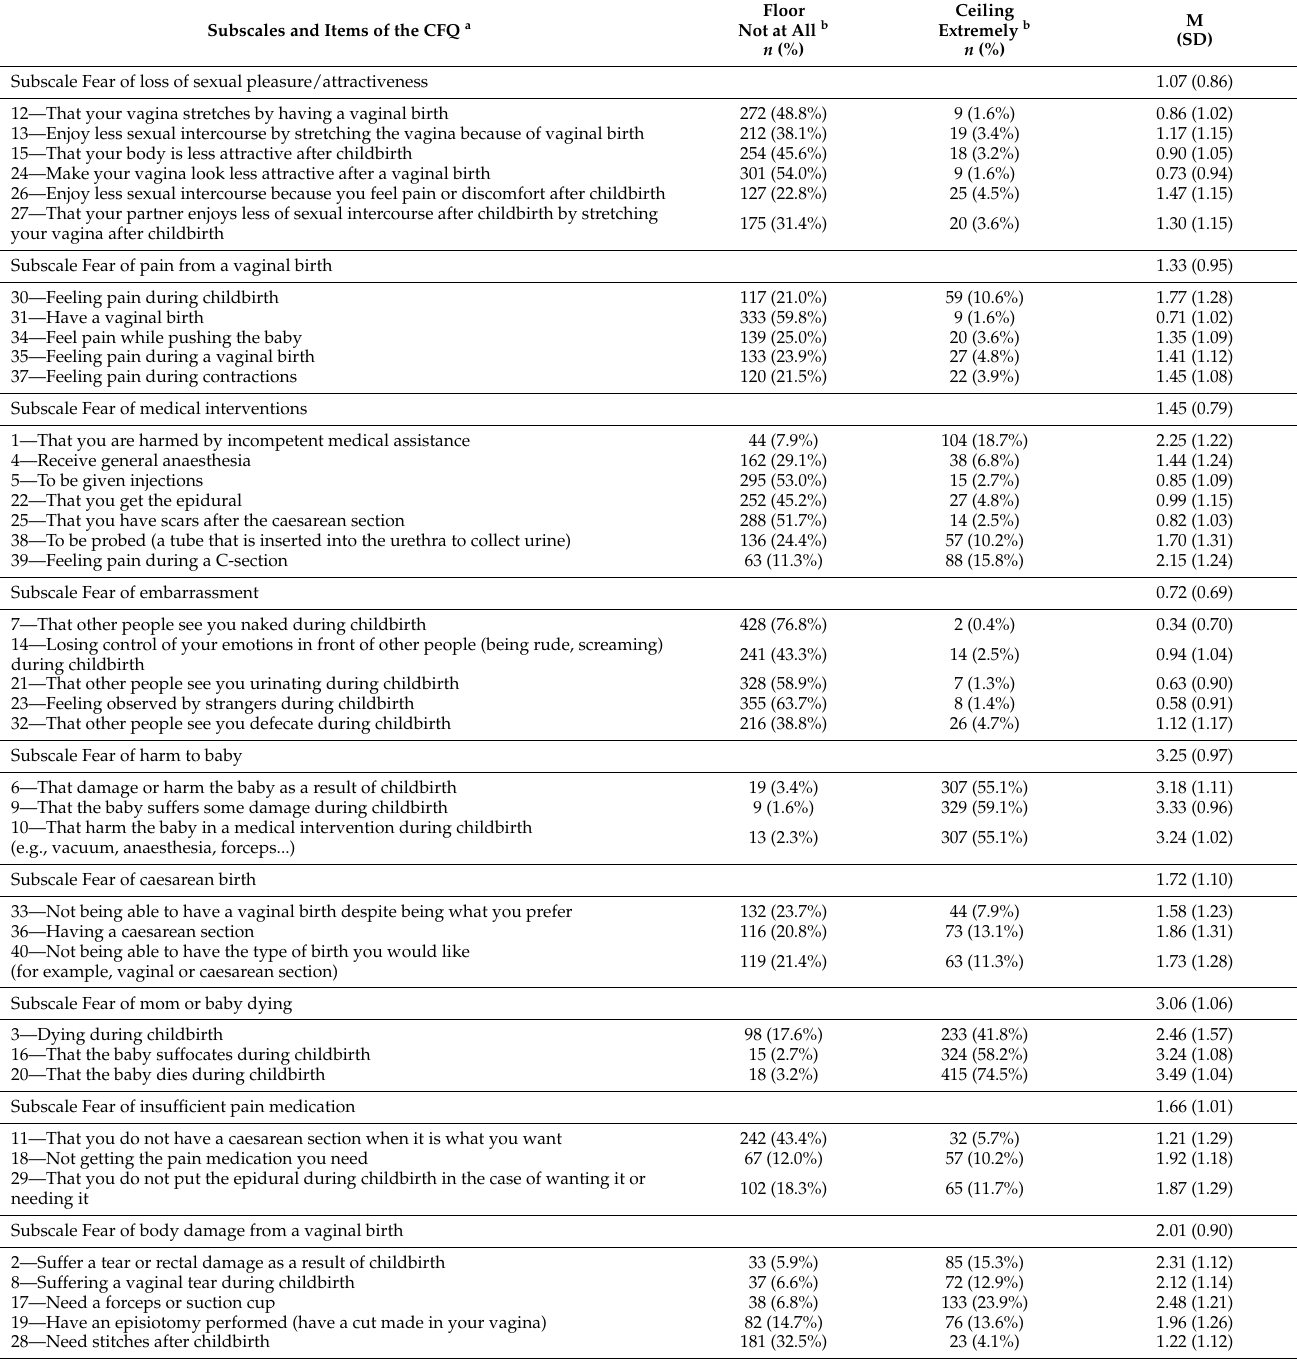
Table 2. Floor and ceiling scores and means and standard deviations for each of the items in the CFQ-e ( n =